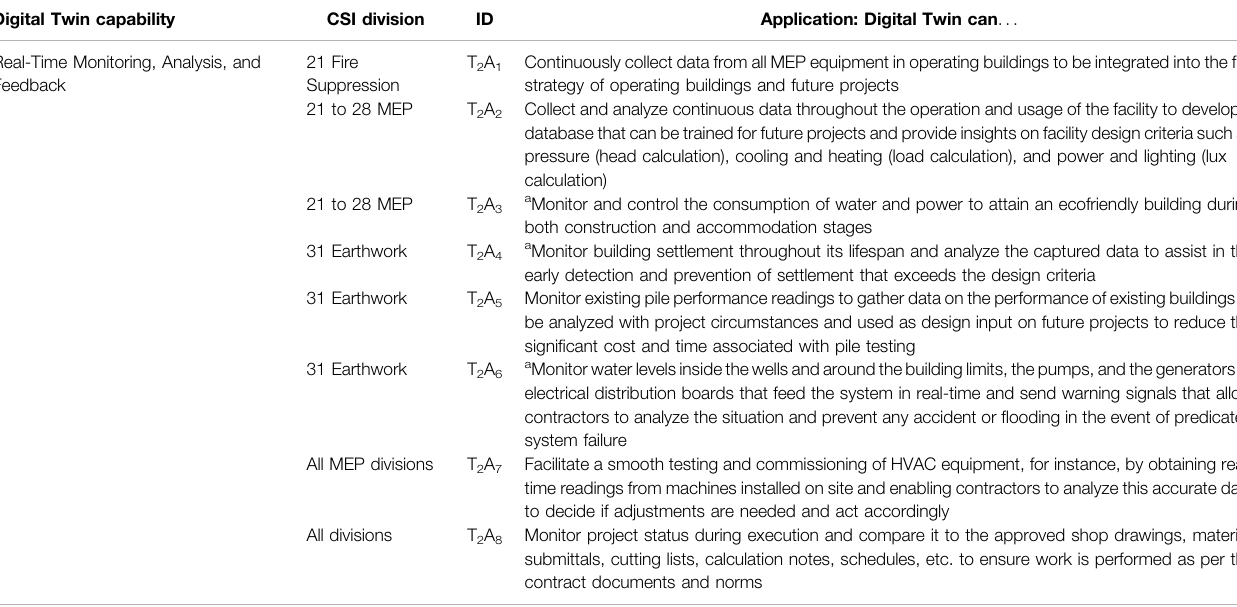
TABLE 4 | Digital Twin capability of Real-Time Monitoring, Analysis, and Feedback and the identi fi ed applications. Digital Twin capability CSI division ID Application: Digital Twin can